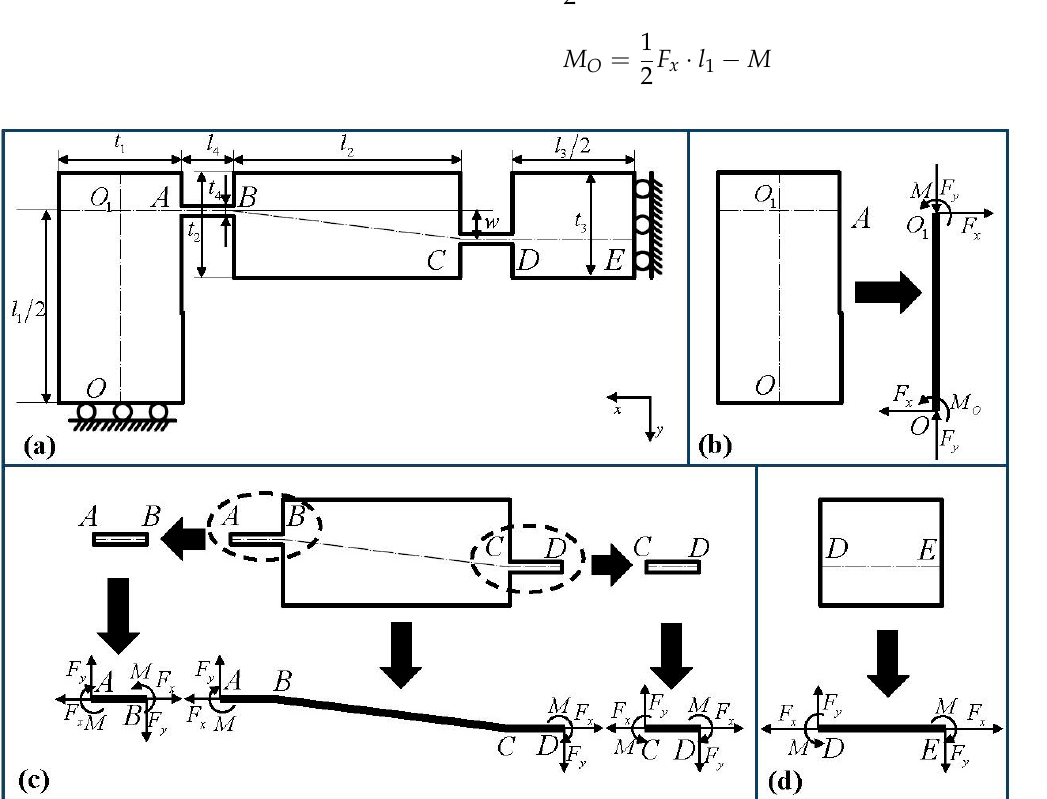
Figure 2. Mechanical analysis diagram of the bridge-type displacement amplification mechanism. ( a ) The 1/4 integral mechanism. ( b ) Input body. ( c ) Connecting body and flexible hinges. ( d ) Output